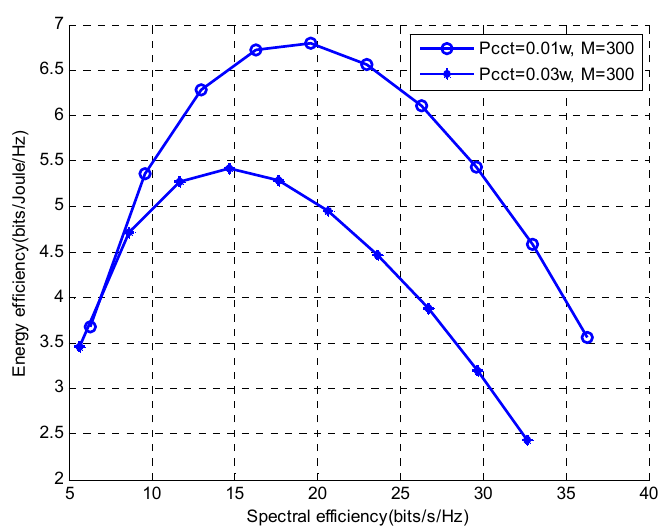
Figure 9. Energy Efficiency vs. Spectral Efficiency under the effect of pilot contamination in multi-cell system with L = 7, K = 10 and transmit power = 10 dB.